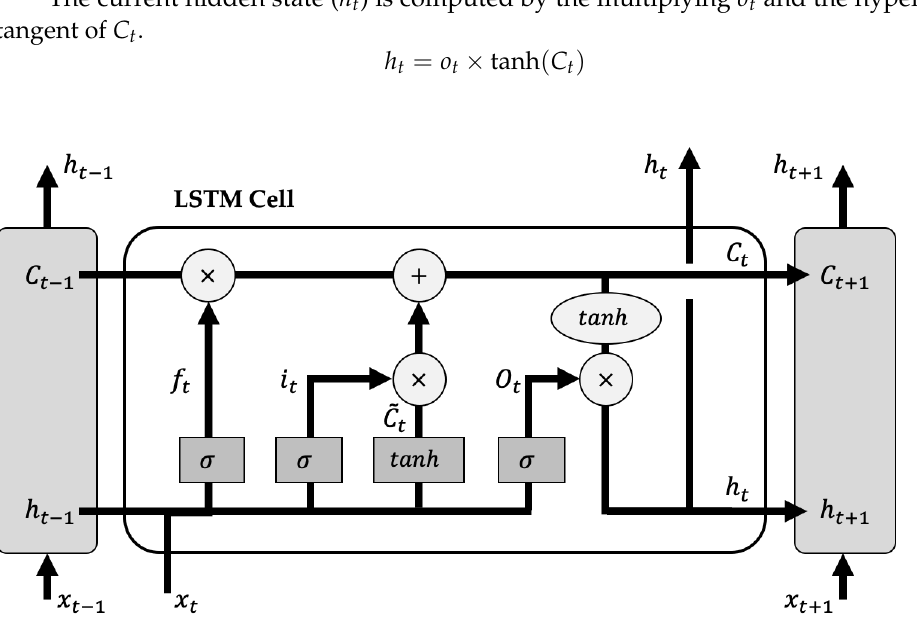
Figure 4. The structure of an LSTM